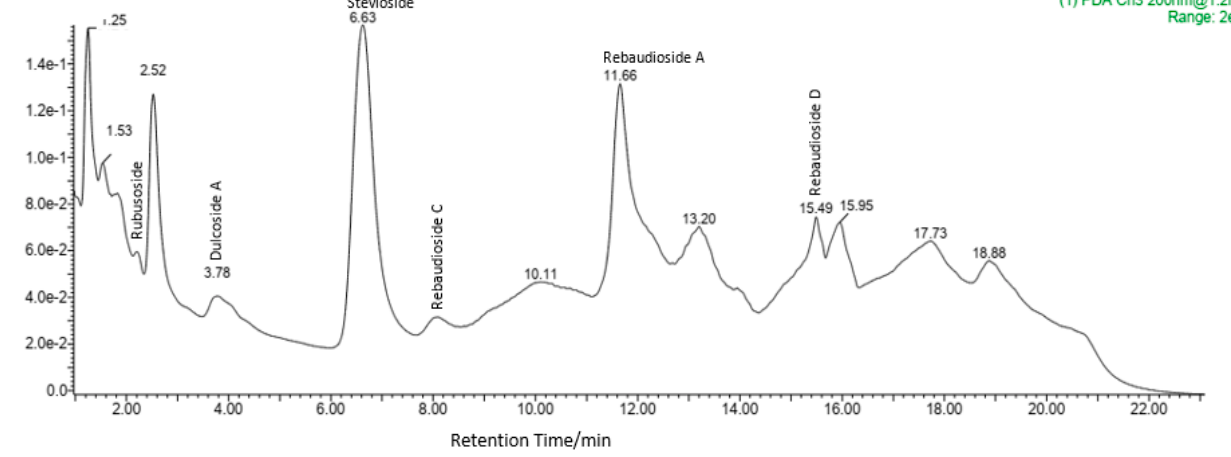
Figure 2. Typical chromatogram of a Stevia leaf extract recorded at a wavelength of 200